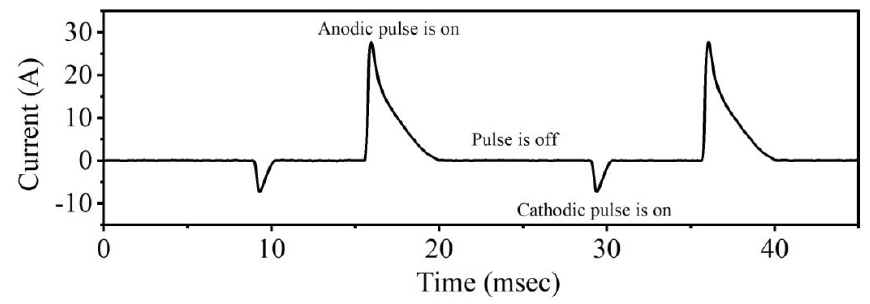
Figure 1. The current waveform during pulse alternating current (PAC) synthesis.